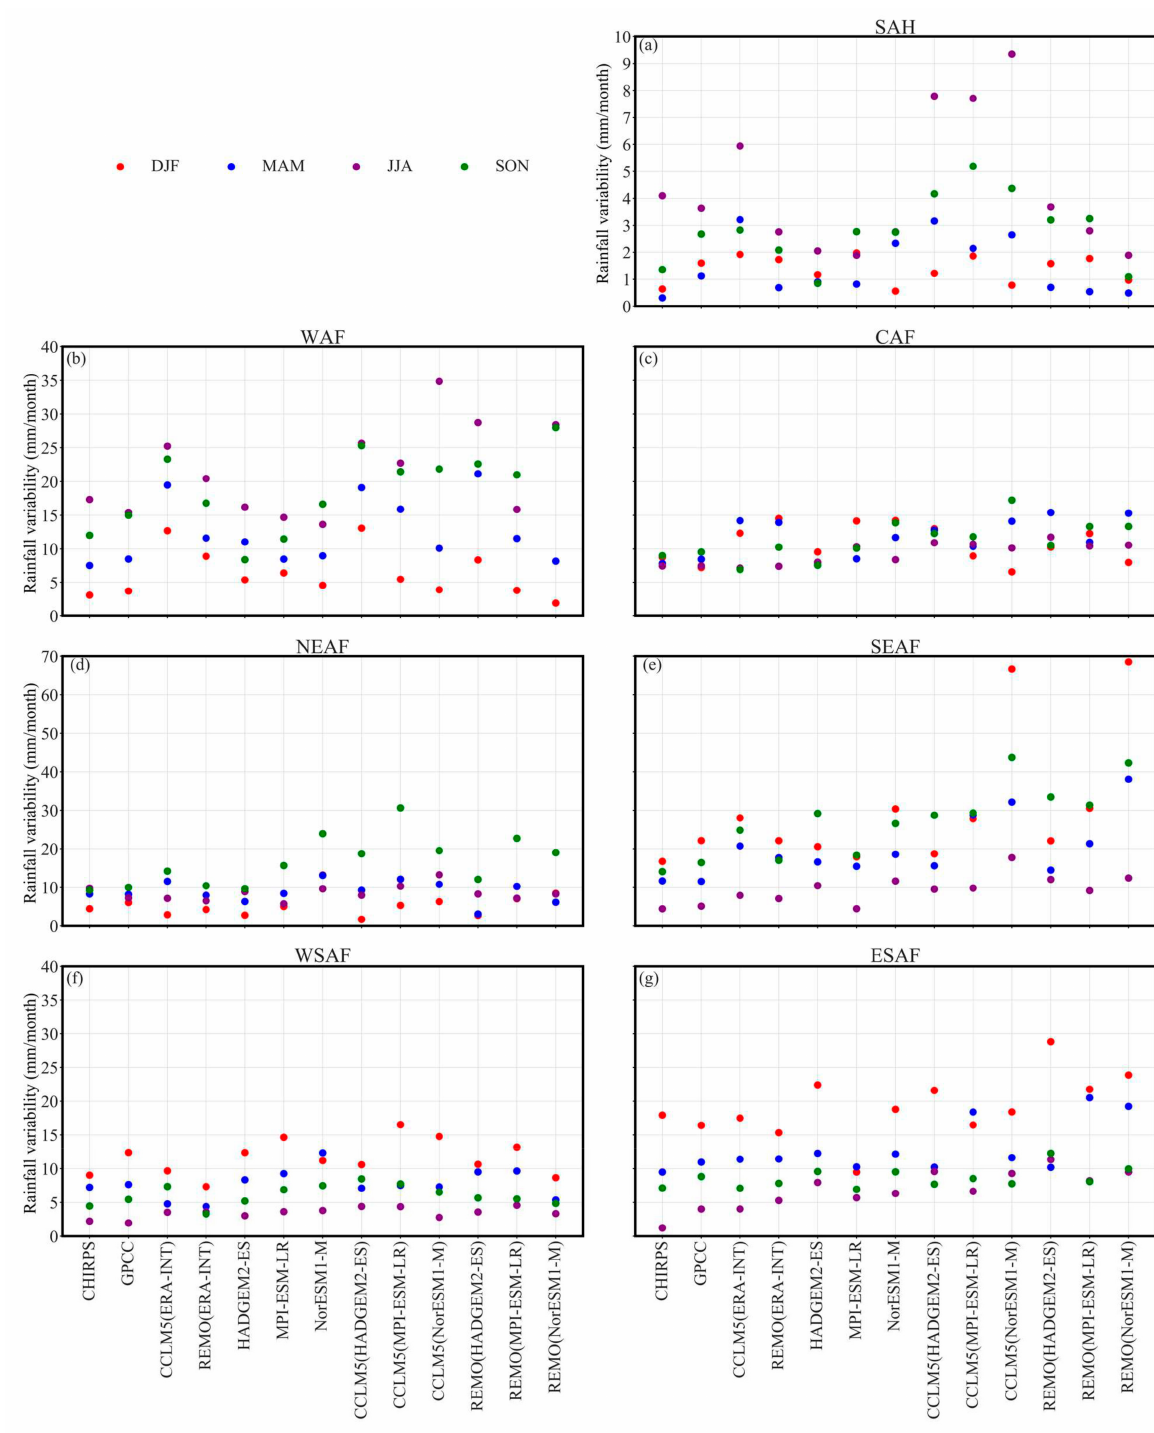
Figure 7. Seasonal variability (mm/month) over the regions indicated in Figure 1: ( a ) Sahara (SAH) region, ( b ) West Africa (WAF) region, ( c ) Central Africa (CAF) region, ( d ) Northern East Africa (NEAF), ( e ) Southern East Africa (SEAF), ( f ) Western South Africa, ( g ) Eastern South Africa